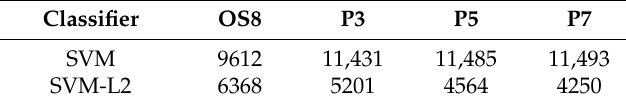
Table 8. Number of support vectors of SVM.